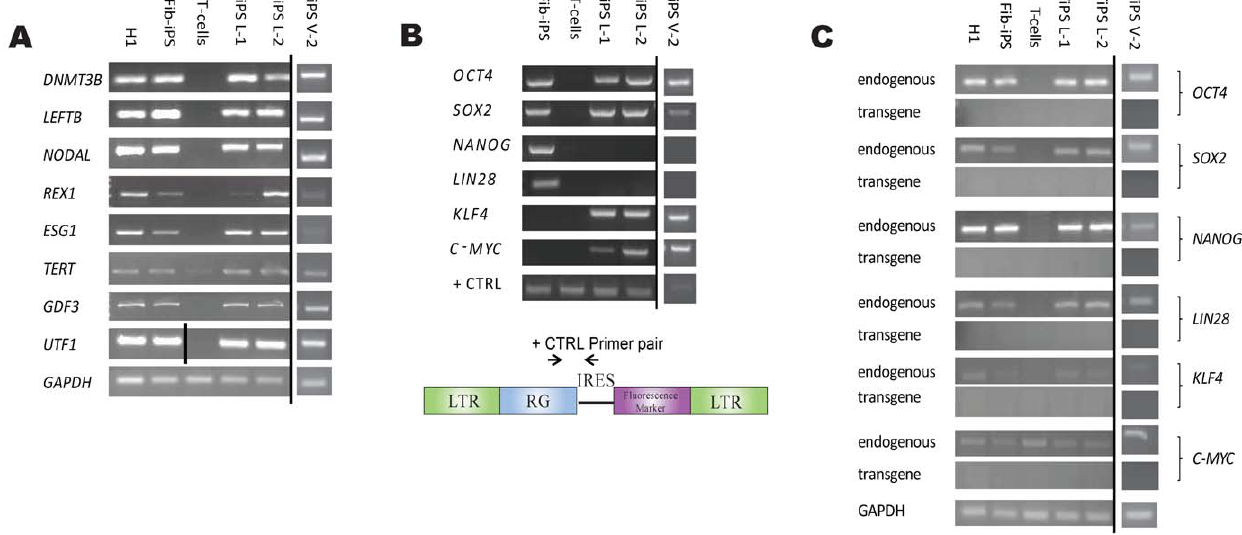
Figure 3. Characterization of induced pluripotent stem cells from human T-cells. (A) RT-PCR analysis of representative leukapheresis (‘‘TiPS L-1’’ and ‘‘TiPS L-2’’) and Vacutainer (‘‘TiPS V-2’’) derived TiPS cell lines for expression of hES cell-marker genes DNMT38 , LEFTB , NODAL , REX1 , ESG1 , TERT , GDF3 , and UTF1 . GAPDH was used as positive loading control for each sample. (B) PCR analysis of genomic DNA confirms integration of the transgenes. Forward primers for the reprogramming gene (‘‘RG’’) of interest and reverse primers for the IRES were utilized. OCT4 forward and reverse primers were used as the PCR reaction positive control, as shown in vector map. (C) RT-PCR analysis of TiPS cell lines shows silencing of the exogenous transgenes, with GAPDH as positive control for each sample. In (A) and (C) hESC line H1 and in (A-C) a fibroblast derived iPSC line (‘‘Fib- iPS’’) served as positive cell controls, and activated donor T-cells served as a negative cell control. In (A-C) images were modified with Photoshop software to combine gels and remove redundant control data from separate